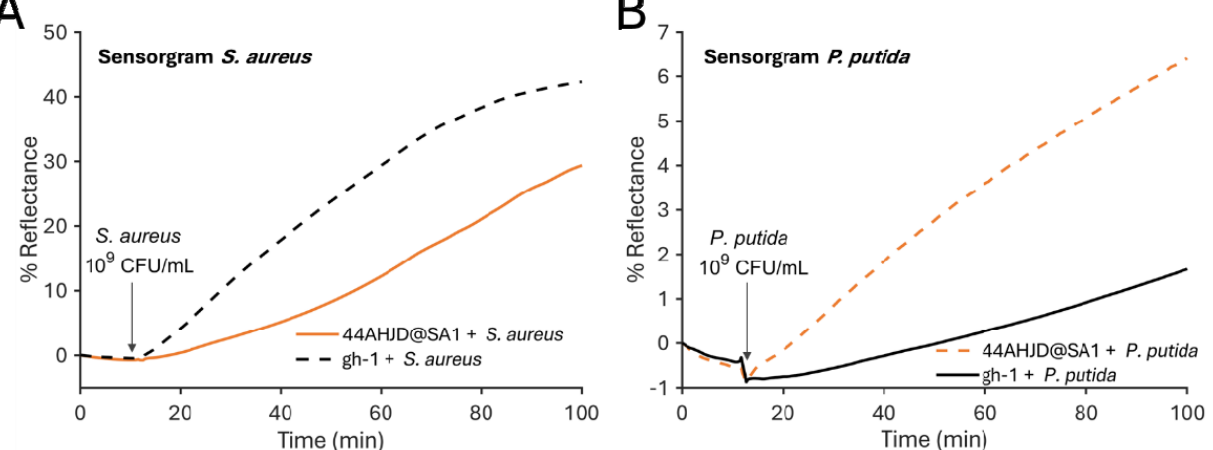
Figure 3. Sensorgrams showing the SPR responses of regions functionalized with phages 44AHJD@SA1 (orange lines) and gh-1 (black lines) when exposed to S. aureus ( A ) or P. putida ( B ). Traces show a one-minute rolling average (i.e., mean of 20 data points).